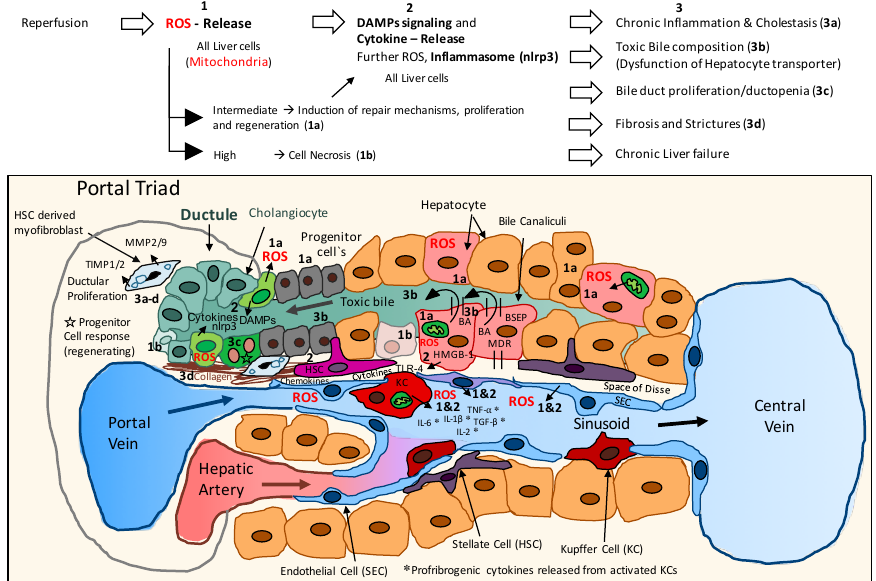
Figure 1. Type and etiology of injury of the biliary tree after liver transplantation. The site and type of biliary complication are highlighted, and potential causes are described throughout the entire biliary tree of a liver graft. Figure 2: Mechanism of cholangiocyte injuryduringandafter reperfusionin the setting of liver transplantation